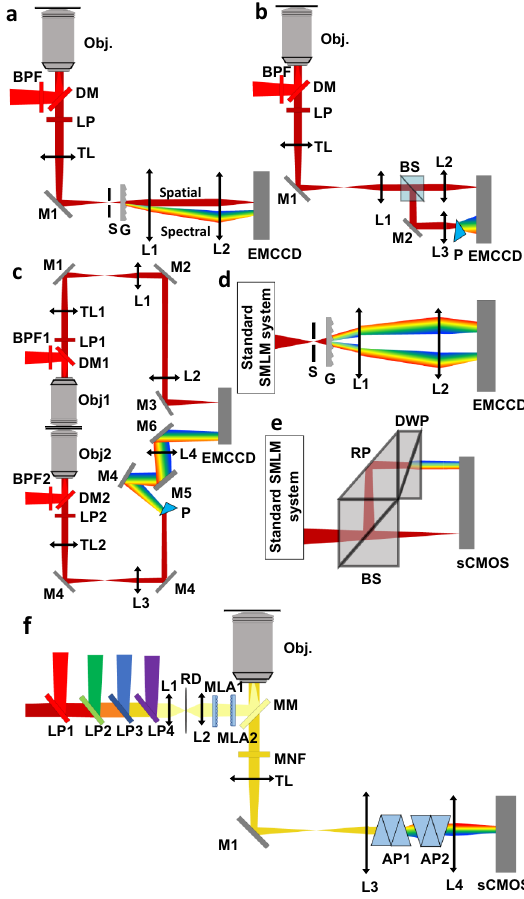
Fig. 2 a Schematic of single-objective, grating-based sSMLM. Obj.: objective lens; DM: dichroic mirror; BPF: band-pass filter; LP: long-pass filter; TL: tube lens; M: mirror; S: slit; G: diffraction grating; L: lens; b Schematic of single-objective prism-based sSMLM. BS; beam-splitter; P: prism; c Schematic of dual-objective, prism-based sSMLM; d Schematic of symmetrically dispersed sSMLM; e Schematic of DWP-based sSMLM. RP: right prism; f Schematic of amici prism-based sSMLM. RD: rotating diffuser; MLA: microlens array; MM: multichroic mirror; MNF: multinotch filter; AP: Amici